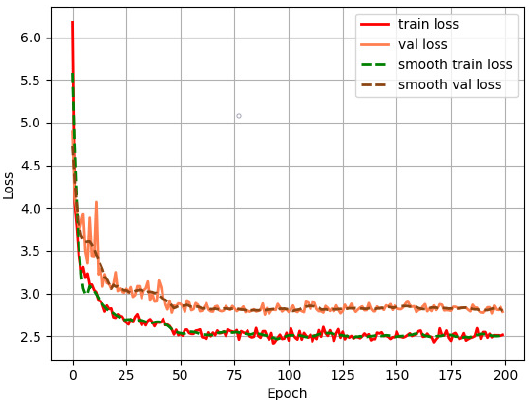
Figure 7. Loss curve of SSD training process.